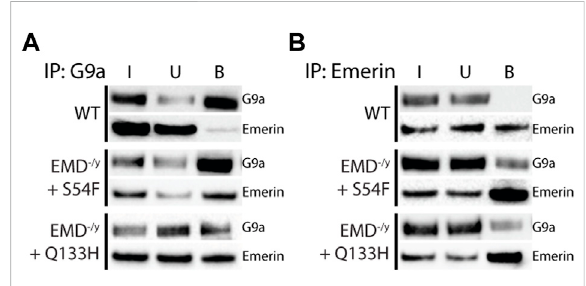
FIGURE 1 Emerin mutants that fail to bind HDAC3 bind more G9a. Immunoprecipitation of G9a or emerin was performed in WT or emerin-null progenitors expressing emerin mutants S54F or Q133H. (A,B) Protein G magnetic beads were incubated with anti-G9a antibody (A; n = 3 for all cell lines) or anti-emerin antibody (B; n = 3 for all cell lines), followed by incubation with whole-cell lysates from each cell line. Input (I), unbound (U),